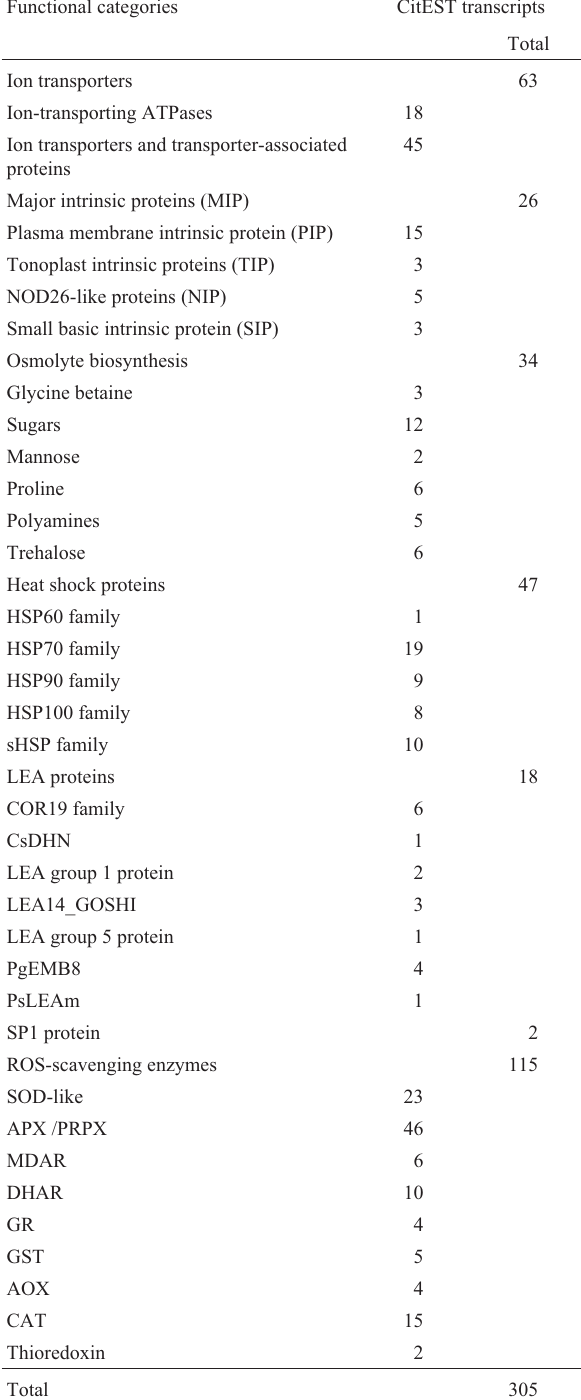
Table 1 - Citrus transcripts identified by tBLASTn searches of CitEST databases whose deduced amino acid sequences show similarity to drought-responsive mechanism